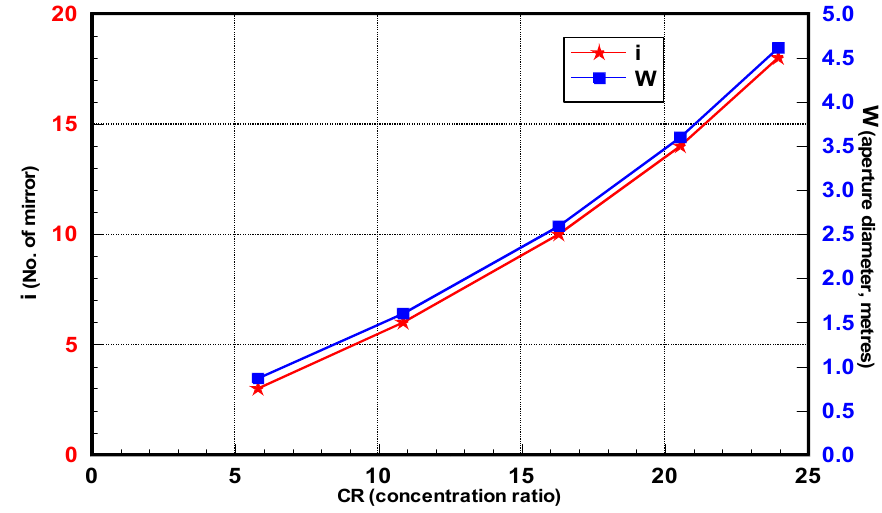
Figure 7. Variation in the number of mirrors and aperture width plotted against the concentration ratio with a constant focus distance of the concentrator aperture ( F = 1 m), absorber width a = 0.125 m.